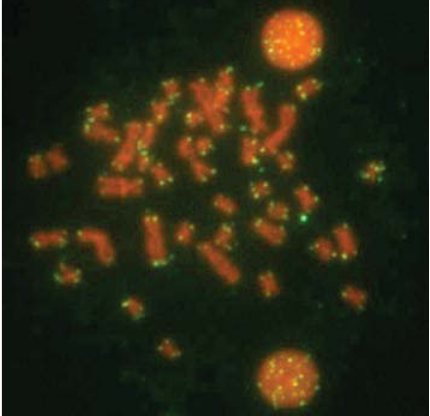
Figure 2 - Metaphase of Imparfinis hollandi after fluorescence in situ hy- bridization with telomere probe (TTAGGG) n